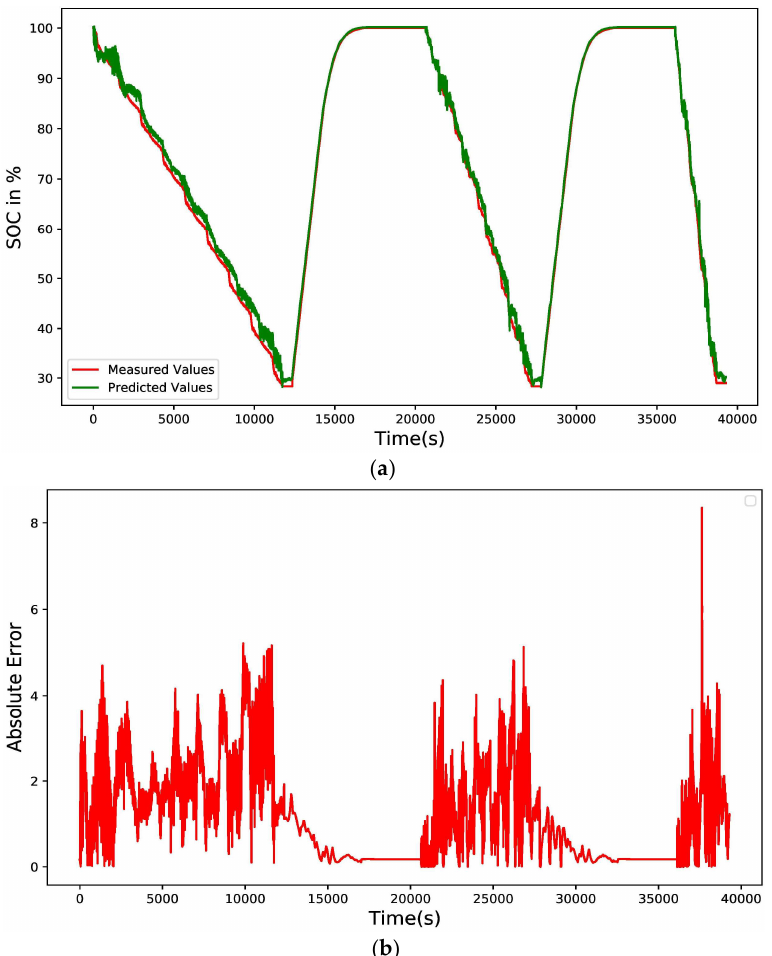
Figure 13. Performance of the GRU model at −10 °C ( a ) measured and predicted SOC values and ( b ) absolute errors from the test data.